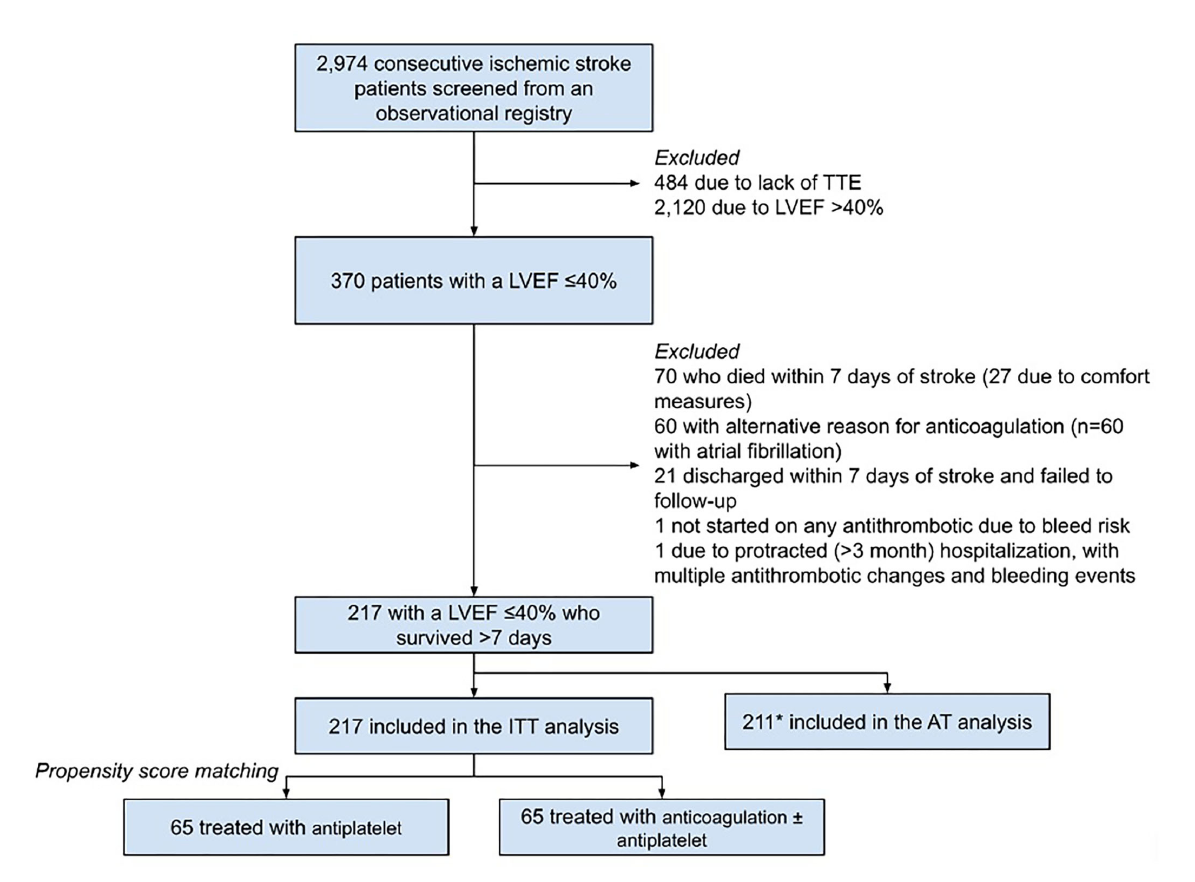
FIGURE1 Inclusion flowchart. *Six patients from the ITT were not included in AT due to discontinuation of antithrombotics at last follow-up for reasons other than significant bleeding event (1 with unclear documentation, 5 with self-discontinuation/non-adherence). TTE, transthoracic echocardiogram; LVEF, left ventricular ejection fraction; ITT, intention-to-treat; AT, as-treated.